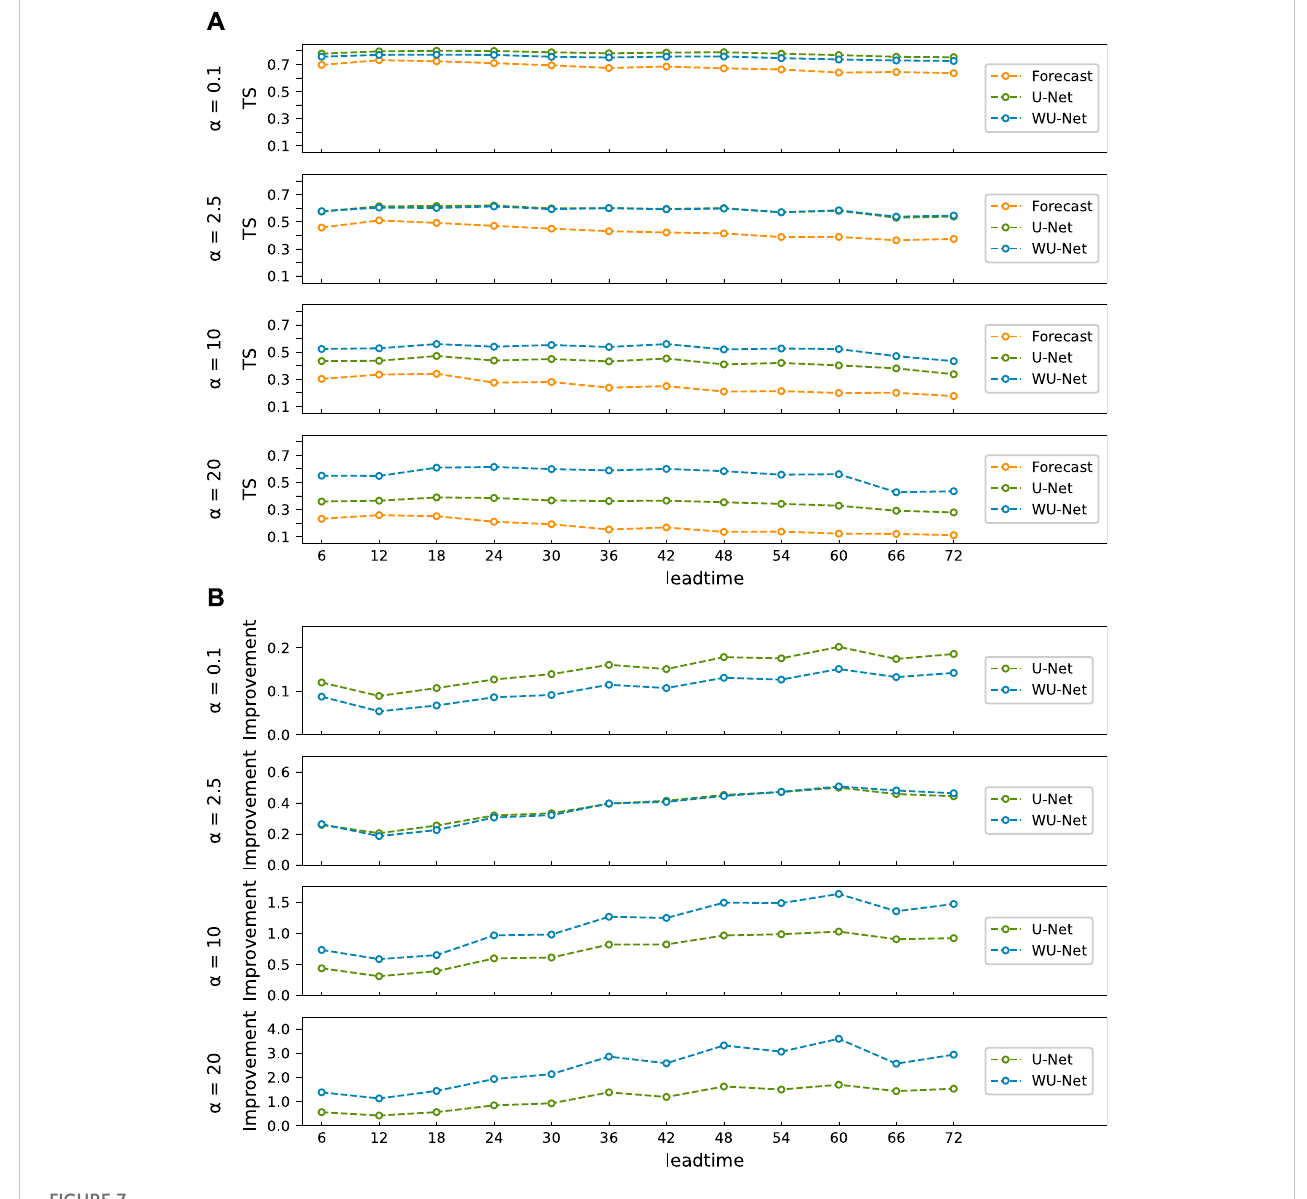
FIGURE 7 (A) ThevariationofTSfortheECMWF-IFS,U-NetandWU-Net,fromtoptobottom:thresholds0.1,2.5,10,and20 mm. (B) TheTSimprovementofU-Net and WU-Net on the ECMWF-IFS as percentage, from top to bottom: thresholds 0.1, 2.5, 10, and 20 mm. The orange, green and blue represent the ECMWF- IFS, U-Net and WU-Net,